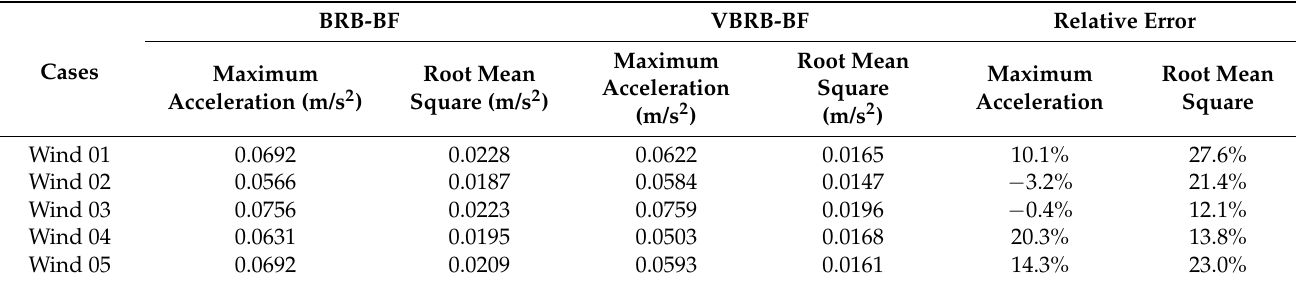
Figure 18. Average values of wind-induced structural responses: ( a ) distributions of maximum lateral drift ratio; ( b ) roof acceleration time-histories; and ( c ) roof displacement time histories. Table 8. Structural wind-induced vibrational